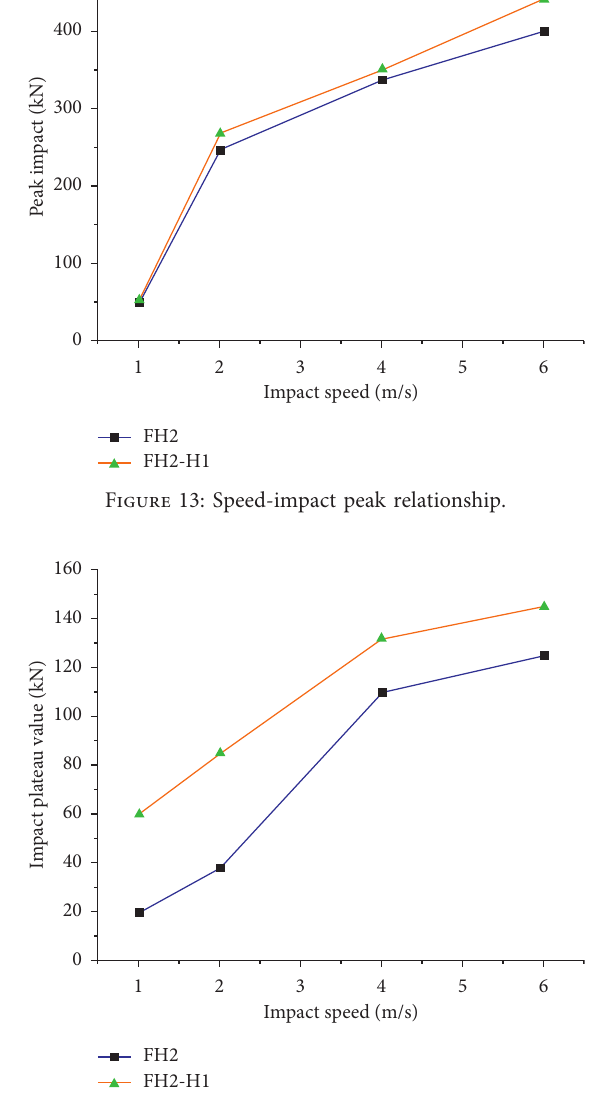
Figure 14: Speed-impact plateau value relationship.